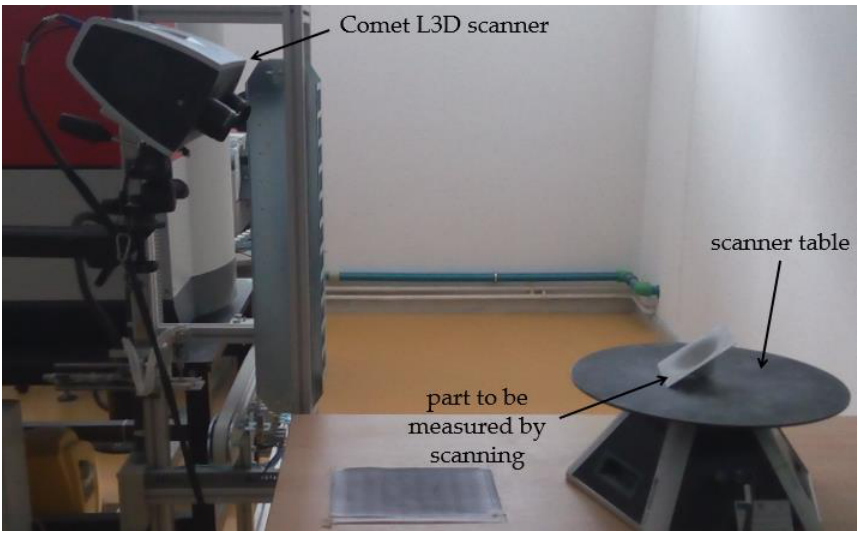
Figure 11. Scanning measuring setup, reprinted with permission from ref. [5].